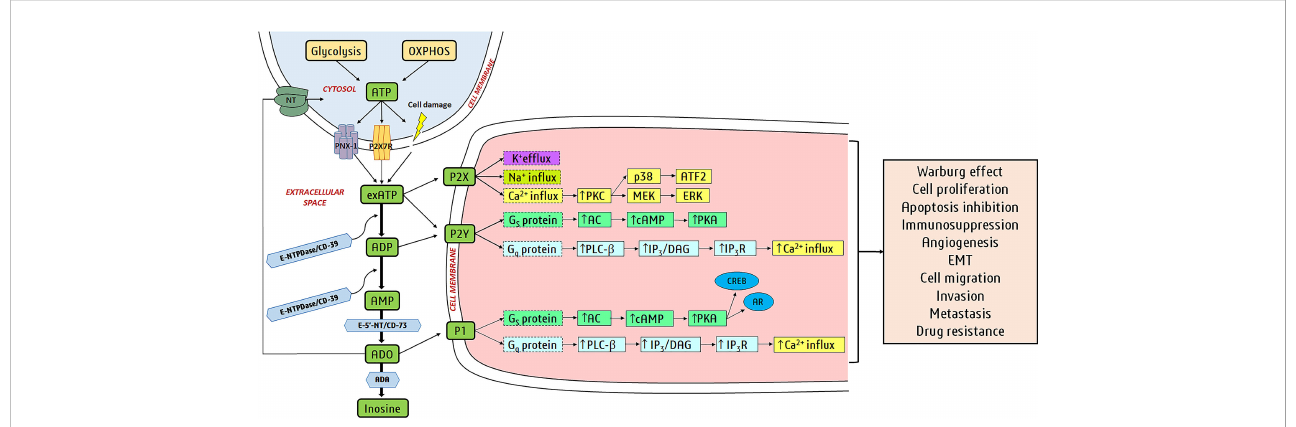
FIGURE 1 Purinergic signaling in cancer: Glycolysis and oxidative phosphorylation (OXPHOS) produce ATP in the cell, and it is released via cellular lysis, pannexin-1 (PNX-1) hemichannels, P2X7R, etc. to extracellular space. Cell membranes have several purine-hydrolyzing enzymes known as ectonucleotidases and include ectonucleotide triphosphate diphosphohydrolases (E-NTPDases/CD39), ectonucleotide pyrophosphatase/phosphodiesterases (E-NPPs), alkaline phosphatases (APs), and ecto-5 ’ -nucleotidases (E-5 ’ -NT/CD73). E-NTPDases hydrolyze exATP to ADP and also ADP to AMP. exATP activates ionotropic P2X receptors (ligand-activated ion channels) and metabotropic P2Y receptors (members of GPCR superfamily). AMP is hydrolyzed to ADO by E-5 ’ -NT and APs. CD39 and CD73 hydrolyze exATP to ADP and AMP to ADO in cancer cells. ADP activates P2Y receptors and ADO activates P1 receptors (member of the GPCR family). ADO is hydrolyzed to inosine (Ino) by ADA or transported back into the cell by nucleoside transporters (NTs). The binding of purines to purinergic receptors turns on/off downstream signaling pathways. P1/P2Y receptor activation alters adenylate cyclase (AC) or phospholipase C- b (PLC- b ) activity via different G proteins (G s and G q are stimulatory receptors). Activation of P2X receptors induces ion fl uxes (Na + , K + , and Ca 2+ ). All these actions alter the levels of secondary messengers like cAMP, inositol 1,4,5-trisphosphate (IP3), and Ca 2+ . IP3 binds to the IP3R receptors on the endoplasmic reticulum (ER), causing Ca 2+ release from the ER. The secondary messengers regulate downstream proteins like protein kinase C (PKC), protein kinase A (PKA), cAMP response element-binding protein (CREB), androgen receptor (AR), mitogen-activated extracellular signal-regulated kinase (MEK), p38, extracellular signal-regulated kinases (ERK), and activating transcription factor 2 (ATF2). Transcription factors CREB, AR, and ATF2 induce gene expression for cancer development and